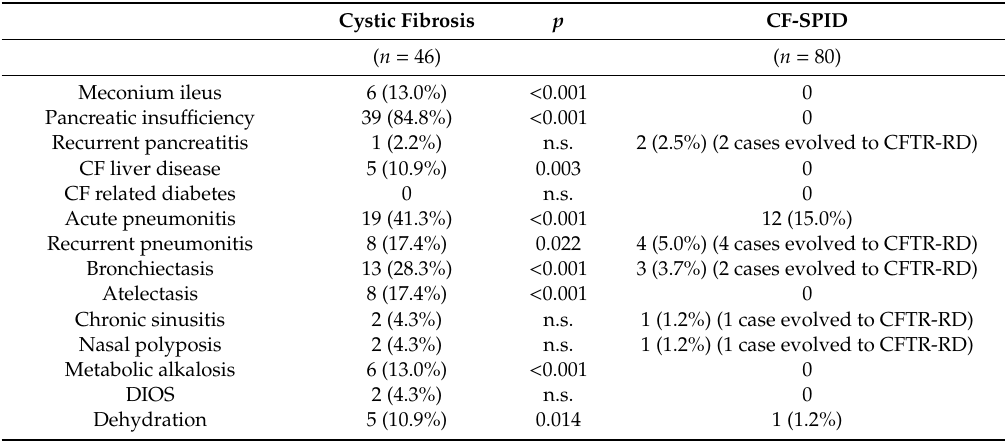
Table 4. Clinical complications in CF and in CF-SPID patients.